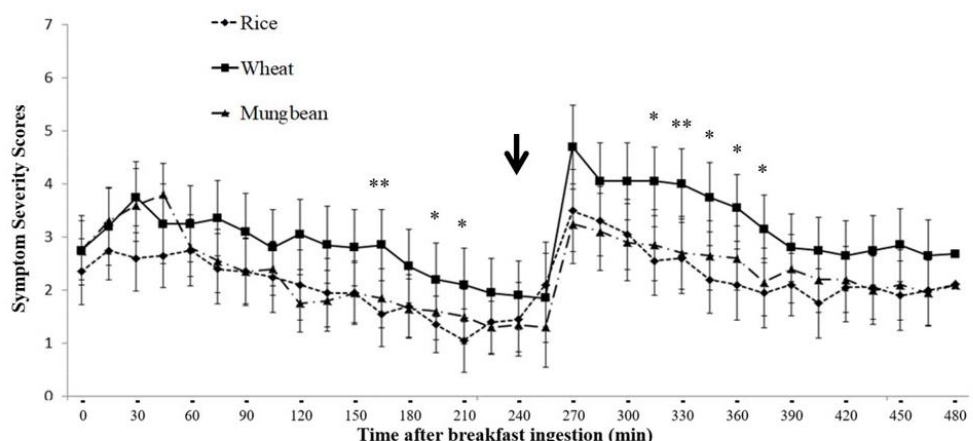
Figure 4. Abdominal bloating symptom severity score at baseline and every 15 min after breakfast until the end of the breath test study (data expressed as mean ± SEM) (arrow = time of lunch ingestion); * = p < 0.05 wheat vs. rice, ** = p < 0.05 wheat vs. rice and wheat vs. mung bean.